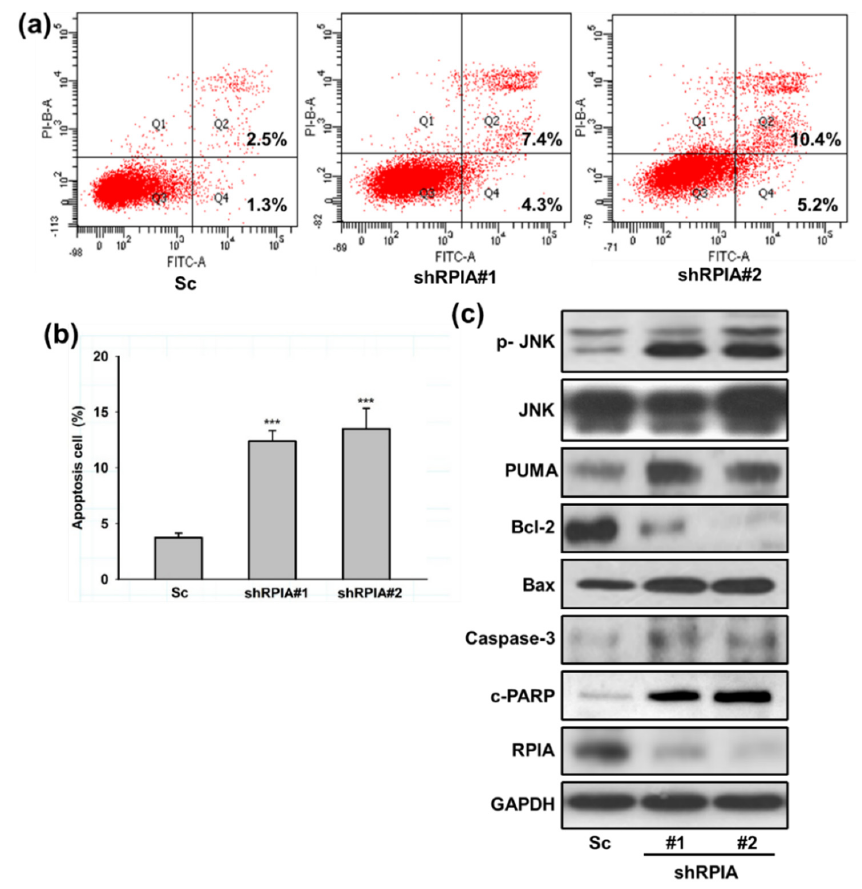
Figure 4. Knockdown of RPIA induced mitochondria mediated apoptosis in lung cancer cells. ( a ) Detection of apoptosis with the Annexin V-FITC/PI assay by flow cytometry. ( b ) Quantification of the ratio of the dead cells (PI positive, AnnexinV-FITC positive, Q2) versus the early apoptotic cells with intact membranes (PI negative, Annexin V-FITC positive, Q4), *** p < 0.001. ( c ) Knockdown of RPIA induced the expression of mitochondria mediated apoptosis related proteins (p-JNK, PUMA, Bcl-2, Bax, Caspase-3, cleaved-PARP) in the A549 cells by Western blot. GAPDH was used as an internal